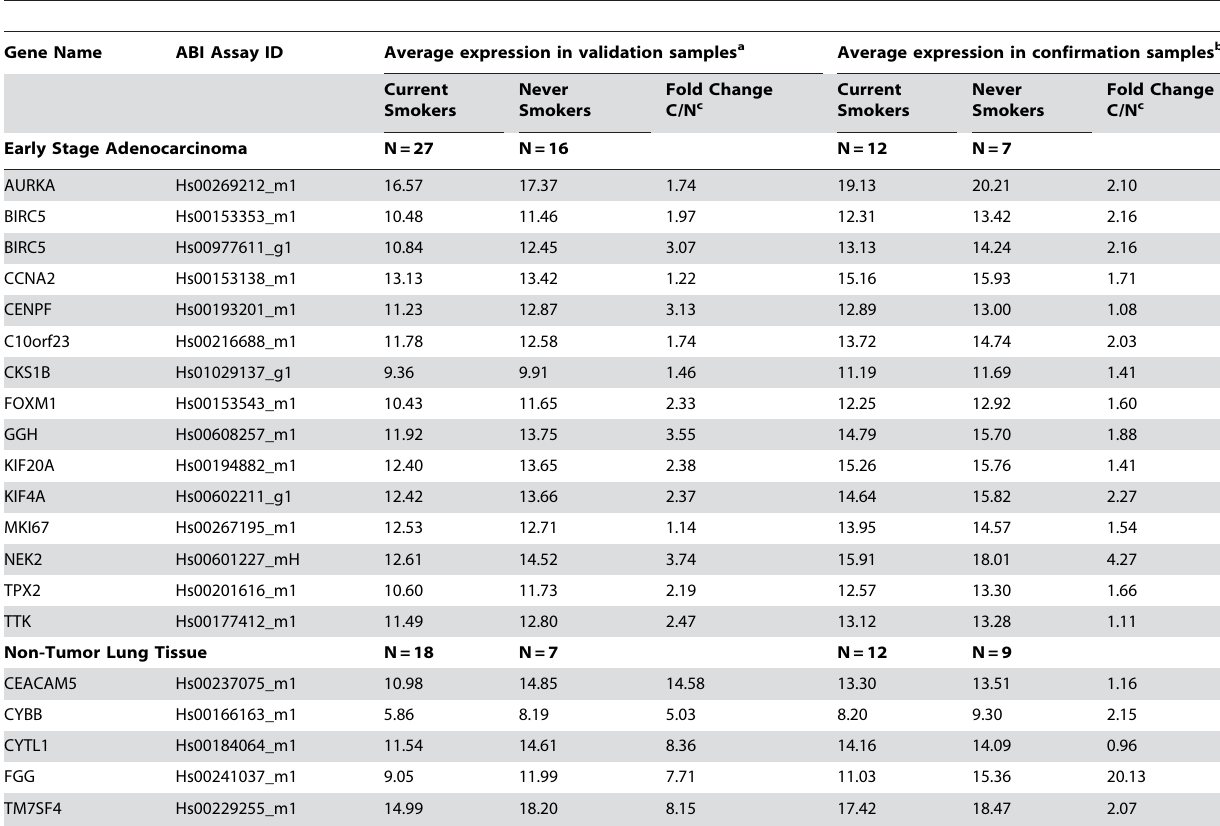
Table 4. Quantitative Real-Time PCR validation of microarray results of genes differentiating current from never smokers (C/N) in tumor (T) and non-tumor (NT) tissue samples and confirmation in independent samples